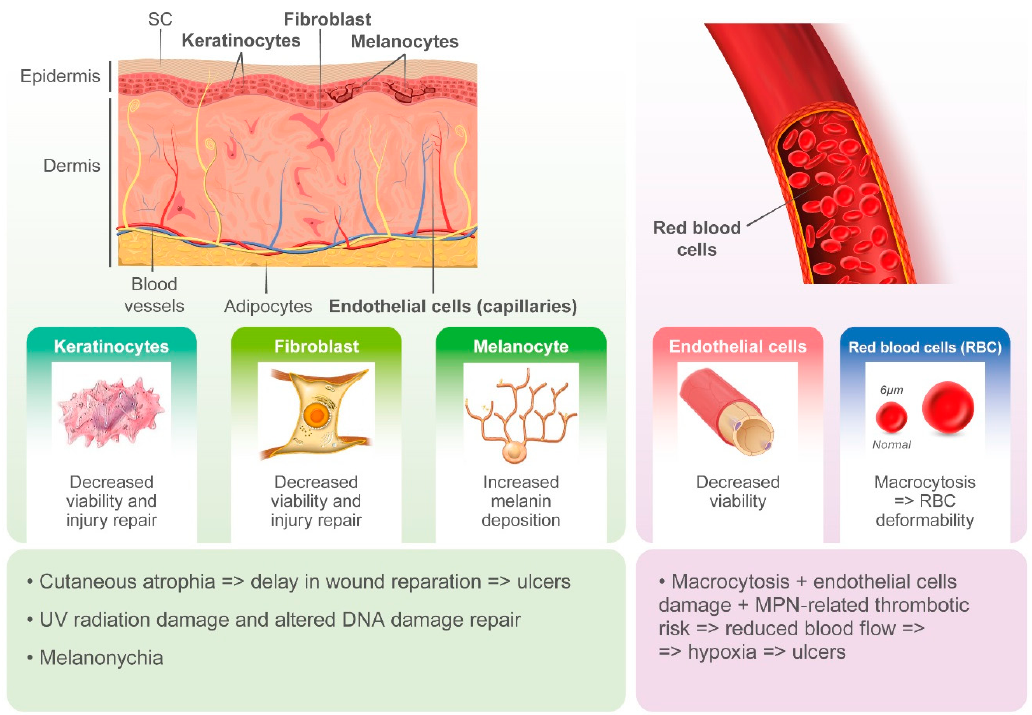
Figure 2. Pathogenesis of hydroxyurea-induced cutaneous toxicity.